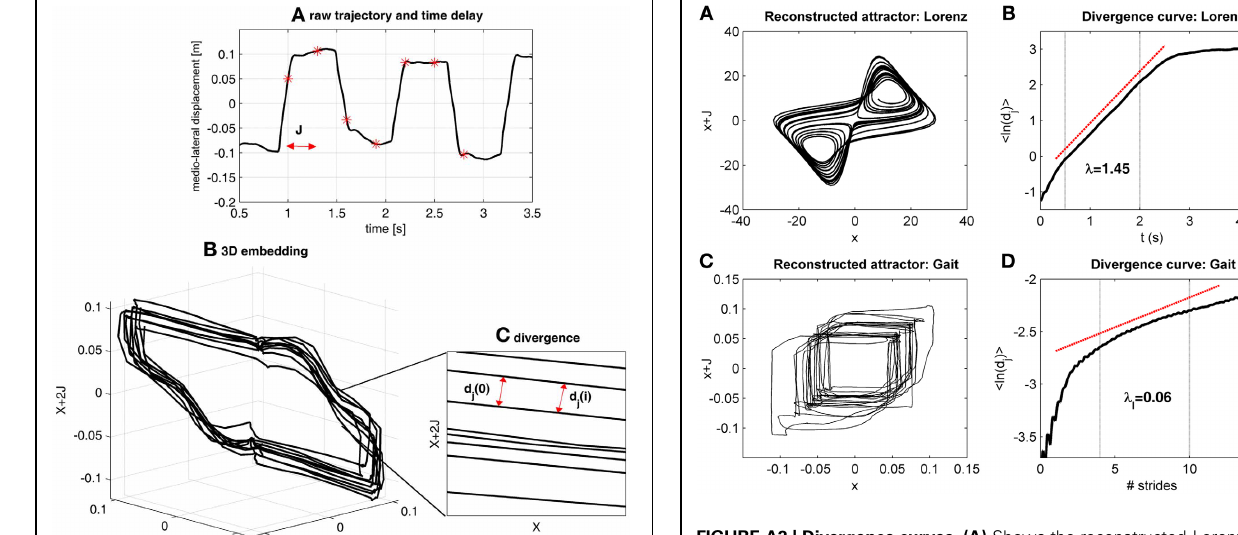
FIGURE A2 | Divergence curves. (A) Shows the reconstructed Lorenz attractor build with the same parameters as in Rosenstein et al. (1993). The corresponding divergence curve (i.e., the logarithmic average divergence as a function of time, Equation A6) is presented in the (B) . The “prominent” linear region between 0.5 and 2s is highlighted by the vertical dotted lines. The linear fit to the curve in that region is highlighted by the red dotted line, and the slope corresponds to the maximal Lyapunov exponent (Equations A5 and A6), λ = 1 . 45. The true Lyapunov exponent for the Lorenz attractor is 1.5. The reconstructed attractor for gait data (mediolateral signal, Figures 1 , A1 ) is displayed in (C) . (D) Shows the corresponding divergence curve, with time normalized by the average stride duration. The time scale for the computation of the long-term LDS (4–10 strides) is shown with the vertical dotted lines. The linear fit is displayed (red dotted line), with the slope value (divergence exponent λ L